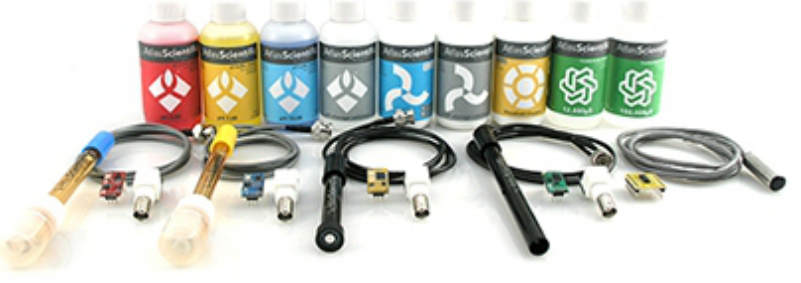
Figure 1. Kit of sensors adopted for water